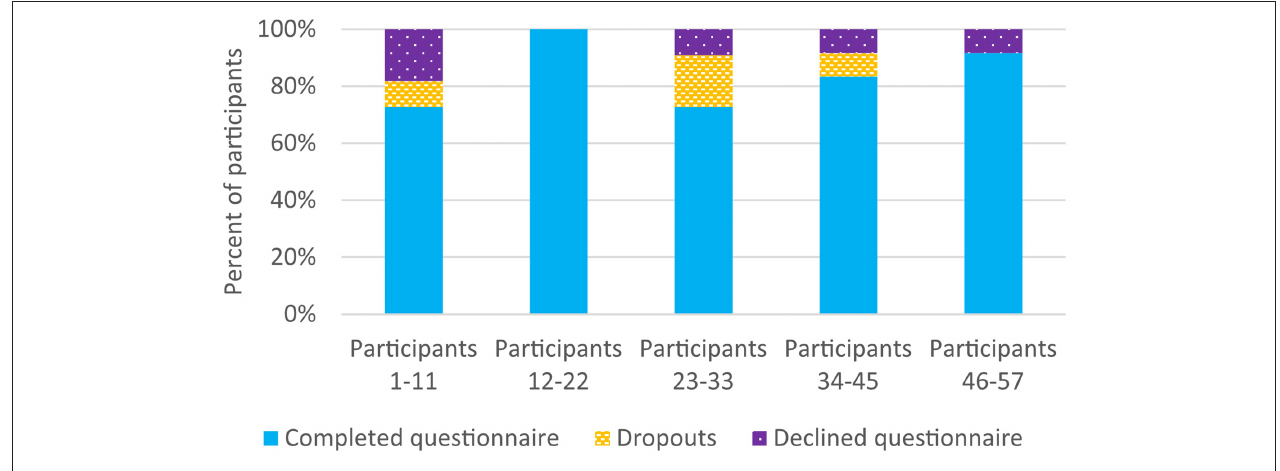
FIGURE 4 | Participation in the baseline questionnaire, divided into five groups according to the inclusion order in the preparatory study.